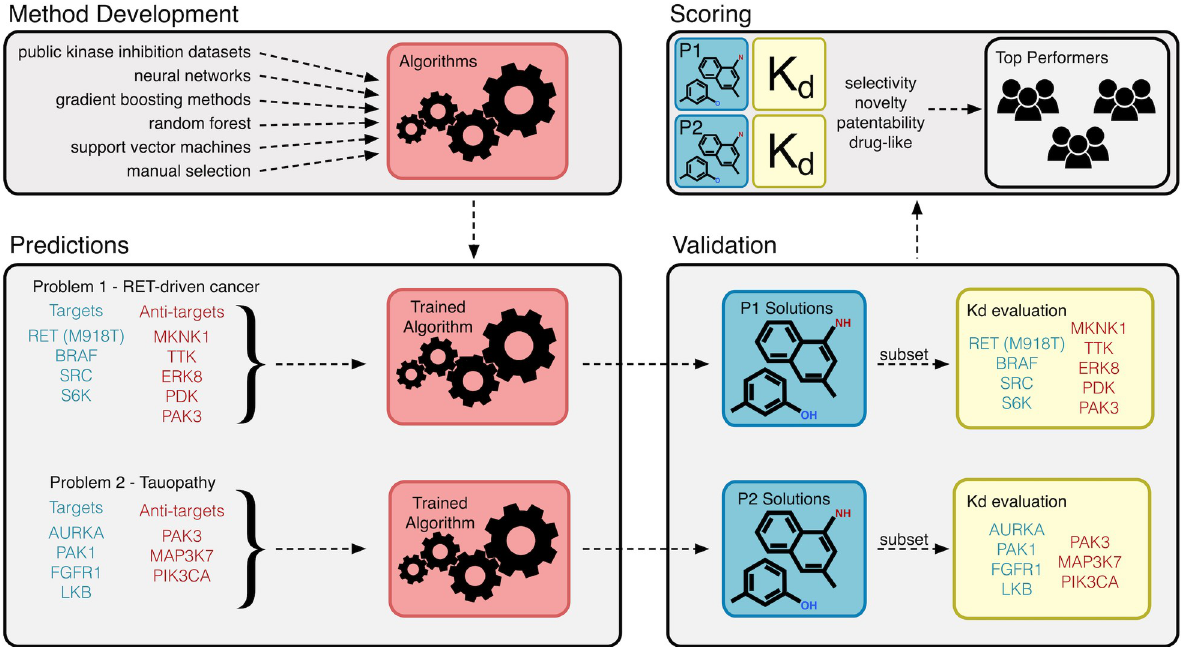
Fig 1. Multi-targeting drug DREAM Challenge overview. This challenge sought to identify new algorithms for the identification of multi-targeting drugs that bind disease-relevant targets and avoid disease-specific anti-targets. Participating teams used a broad array of different datasets and computational approaches to develop these methods. They were then asked to use these methods to predict small molecules that would bind to RET- driven cancer targets and anti-targets (Problem 1, P1) as well as Tauopathy targets and ant-targets (Problem 2, P2). A shortlist of these predicted molecules were then experimentally validated (Kd determination) as binders or non-binders of P1 and P2 proteins. Finally, the submitted compounds were scored using a combination of criteria including selectivity, novelty, patentability, and drug-like properties to identify the top performing